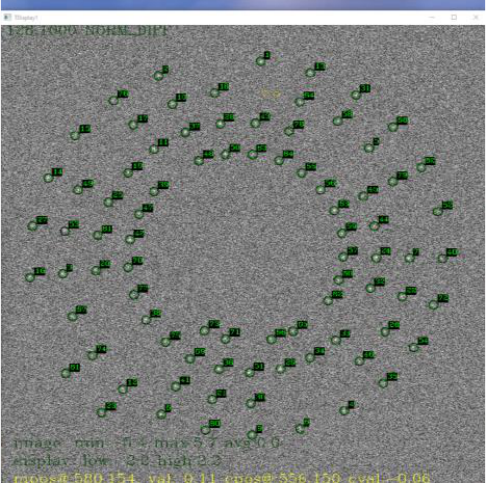
Figure 10. Targets Detected by MMODS overlay on Difference Image.